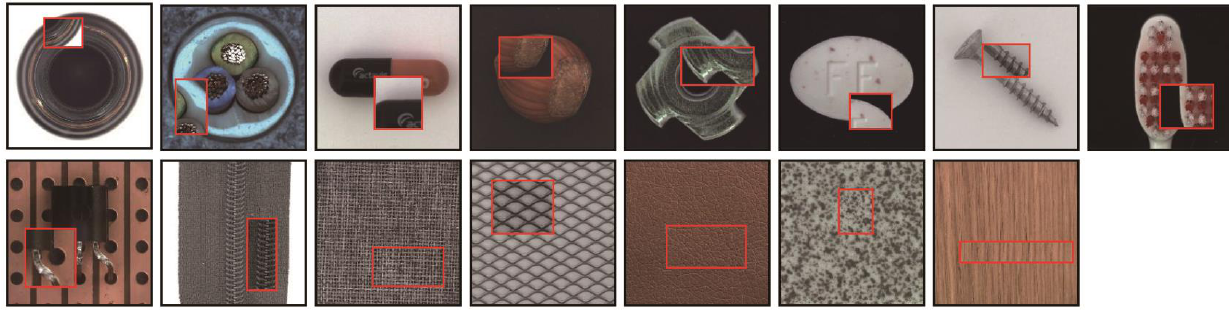
Figure 4. Examples of the image augmentation effect. This method randomly cuts a small rectangular area (the red rectangular boxes) and pastes these into random positions.